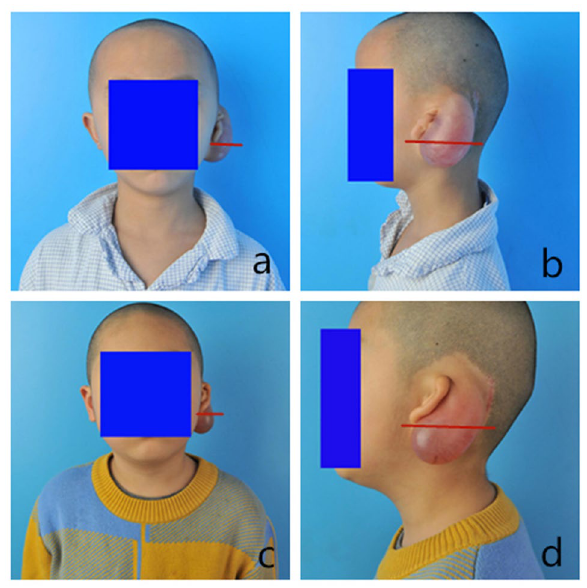
Figure 3. Typical patients in the control group. ( a ) Front view of typical patient 1 in the control group. ( b ) Lateral view of typical patient 1 in the control group. ( c ) Front view of typical patient 2 in the control group. ( d ) Lateral view of typical patient 2 in the control group. The red reference line is the horizontal line of the lowest point of the earlobe of the malformed